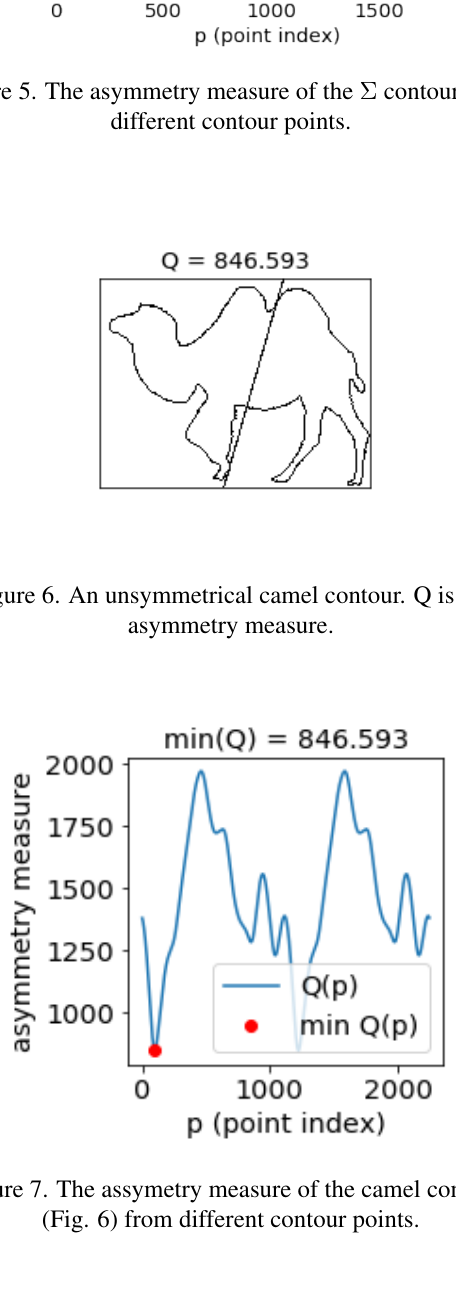
Figure 3. Importance of Fourier coefficients based on absolute values (the bird unsymmetrical contour, Fig. 2).